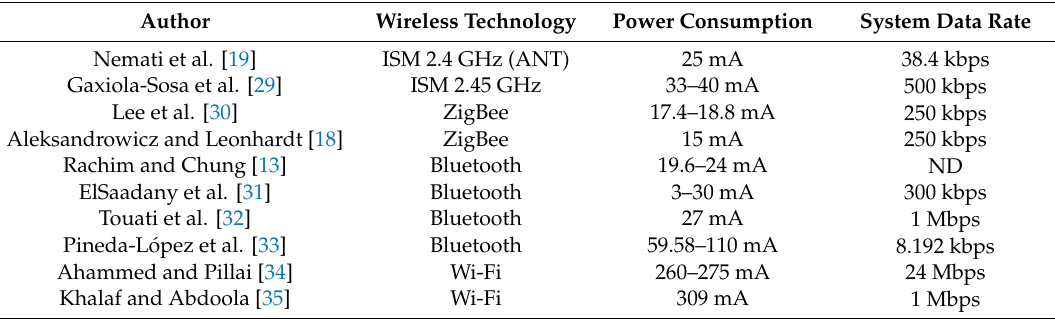
Table 2. Wireless technologies used in ECG monitoring